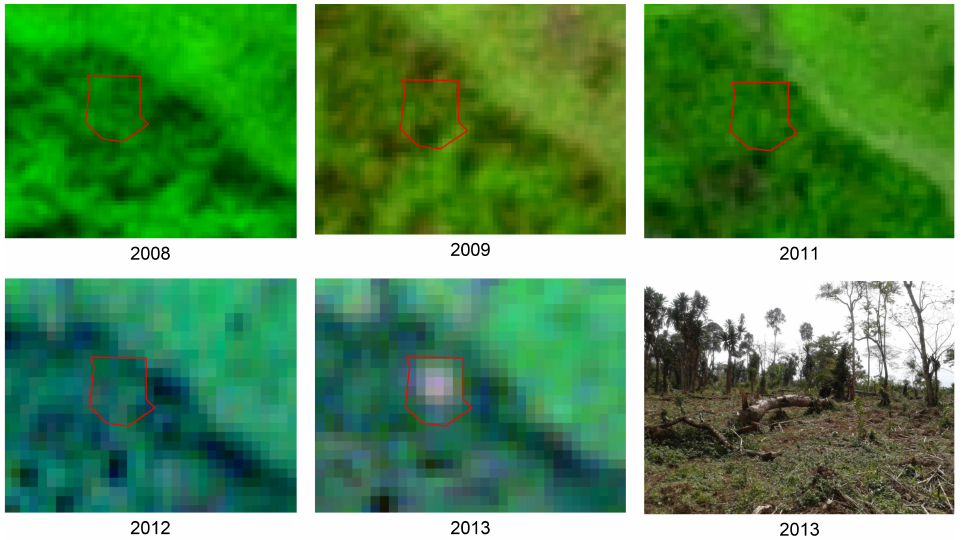
Figure 5. Example of visual interpretation to assess the temporal accuracy of the local expert dataset; the image subset is based on SPOT5 data from 2008 to 2011 (red = Band 3, green = Band 1, blue = Band 2) and two RapidEye images from 2012 and 2013 (red = Band 3, green = Band 2, blue = Band 1); a ground photograph taken by a local expert in 2013 is also shown; the red polygon is the forest change mapped by a local expert; the forest change occurred between 2012 and 2013.